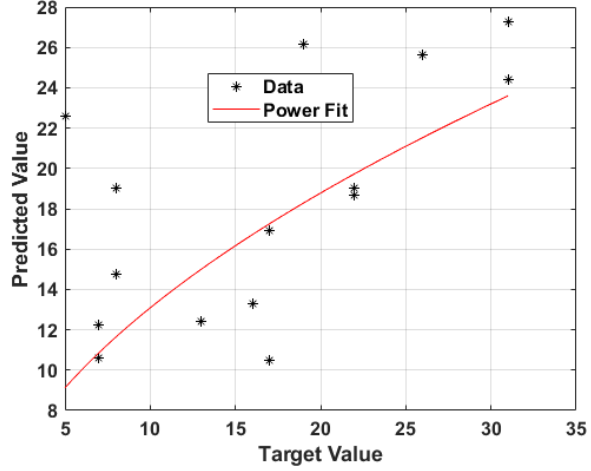
Figure 14. System failure plot of target vs. predicted value for MLR Model 2 testing.